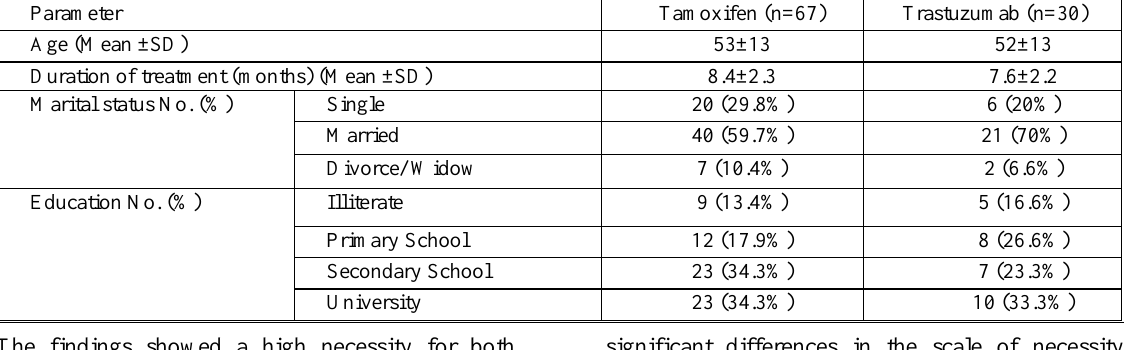
Table 1. Demographic data for the participants. Parameter